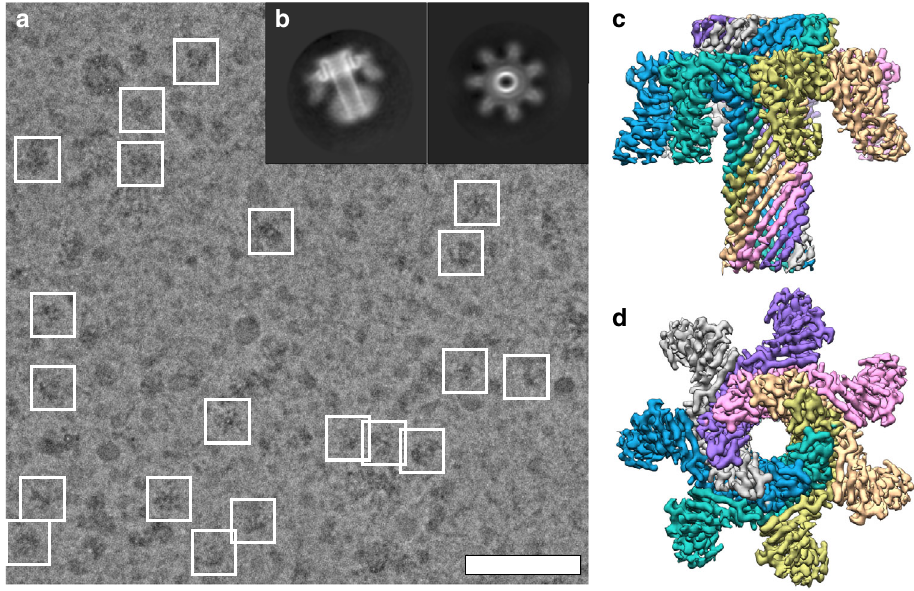
Fig. 2 Cryo-electron microscopy (EM) of epsilon toxin (Etx) pores using the Volta phase plate. a Electron micrograph of a typical fi eld of view of isolated Etx pores. Particles that were included in the fi nal 3D map are highlighted. b Characteristic 2D class averages. Sharpened cryo-EM map of the pore coloured by monomer as visualized from the side ( c ) and extracellular ( d ) views. Scale bar corresponds to 50